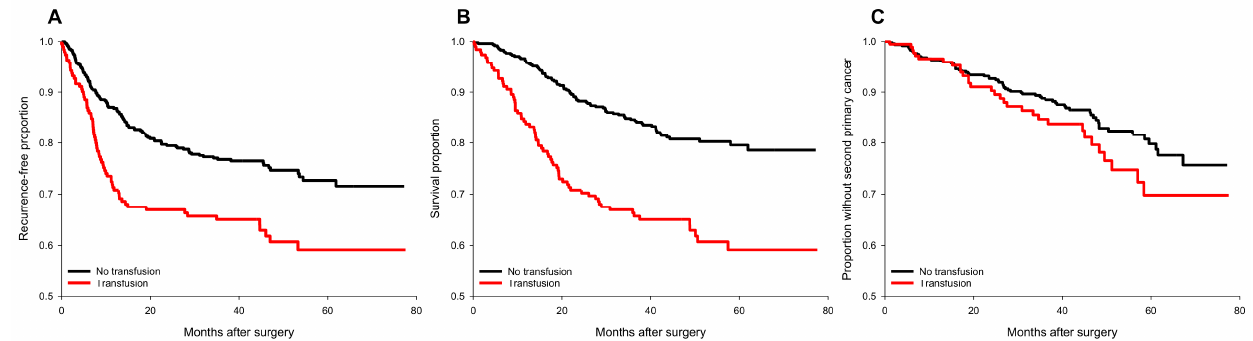
Figure 1. Survival plots of cancer recurrence, all-cause mortality, and occurrence of second primary cancers for transfused and non-transfused patients before IPTW. ( A ) cancer recurrence; ( B ) all-cause mortality; ( C ) occurrence of a second primary cancer. No transfusion group (black line); transfusion group (red line).